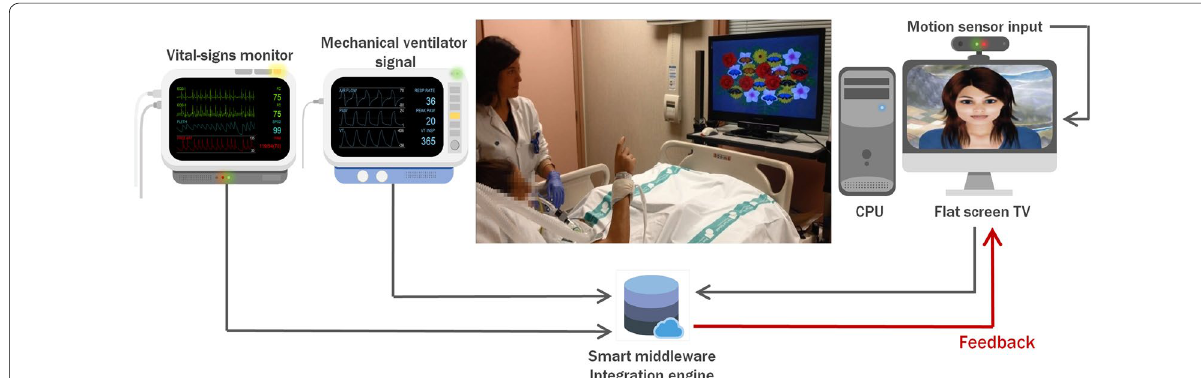
Fig. 1 Schematic diagram of the smart middleware connecting ENRIC platform, bedside monitor and ventilator (screenshots of bedside monitor and ventilator courtesy of BetterCare ® , Barcelona, Spain). The platform uses smart middleware to connect the cognitive stimulation software with input from a motion sensor (Kinect ® , Microsoft, Redmond, Washington, USA) that captures and interprets patient movements. The platform also incorporates a system to collect and store physiological data (BetterCare ® , Barcelona, Spain) from bedside monitors and ventilators that could be used to adapt the level of cognitive stimulation to patients’ clinical